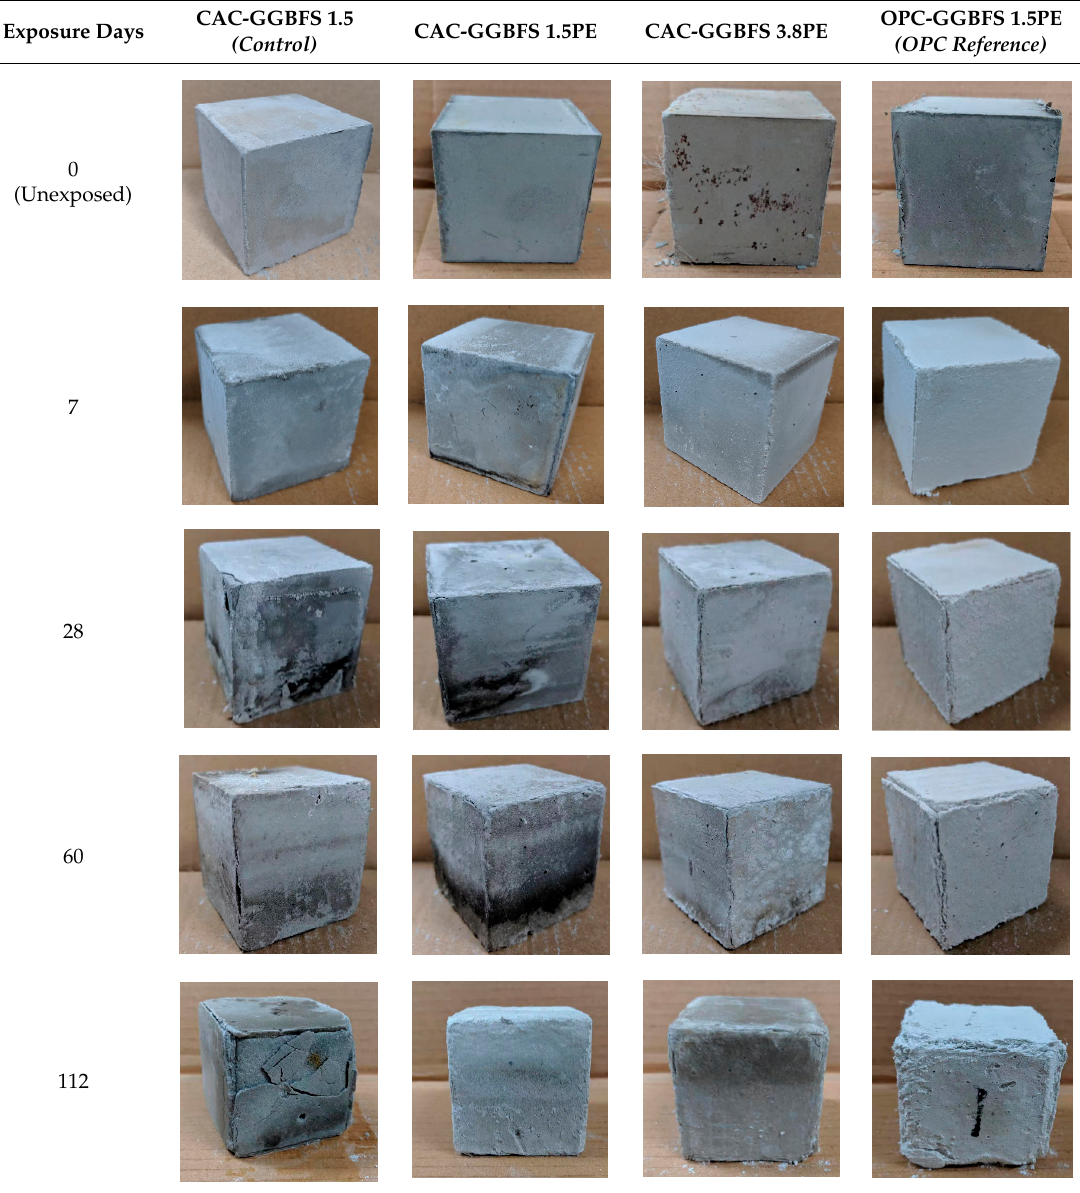
Table 3. Visual observation of samples after di ff erent age of acid exposure.